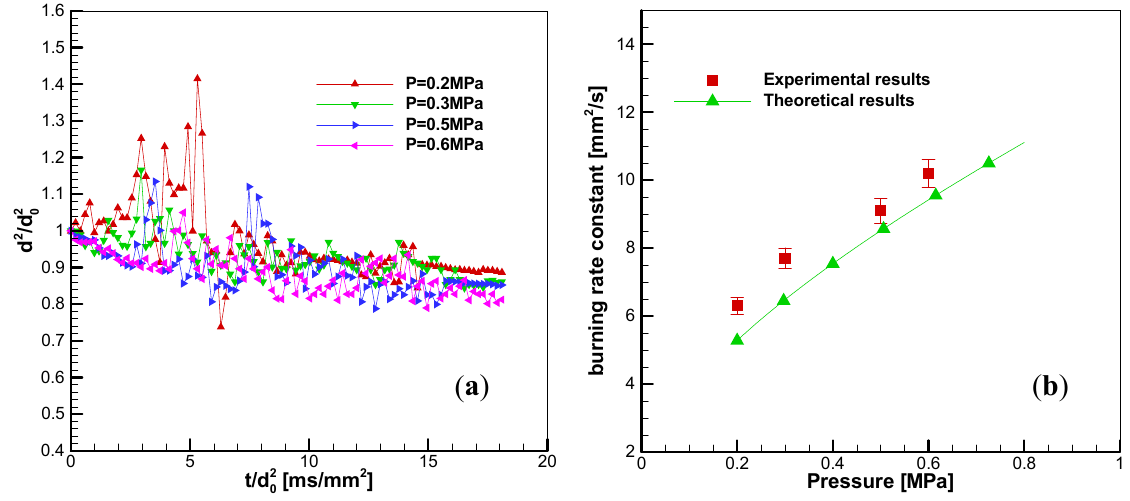
Figure 5. ( a ) Temporal variation of droplet size for different ambient pressure at Y ( b ) Variation of burning rate constant with ambient